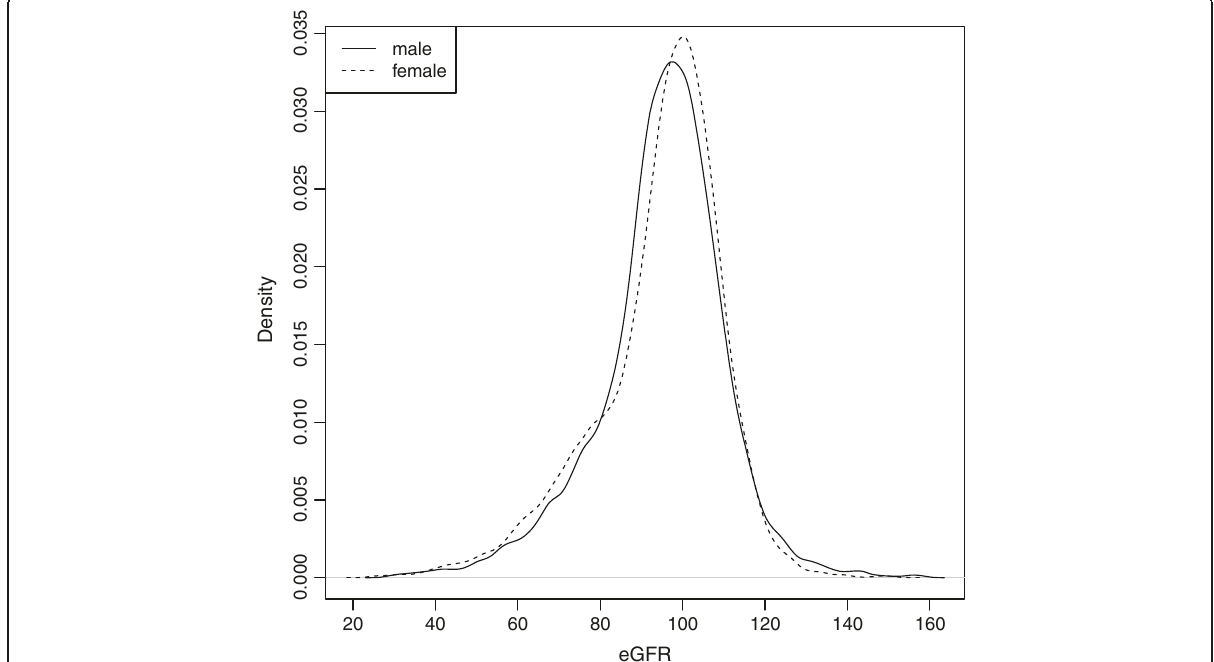
BMI body mass index, SBP systolic blood pressure, DBP diastolic blood pressure, FPG fasting plasma glucose, TC total cholesterol, eGFR estimated glomerular filtration rate, MTHFR methylenetetrahydrofolate reductase. Age, BMI, and blood pressures were given by mean ± sd, serum markers were given by median (Interquartile range, IQR).